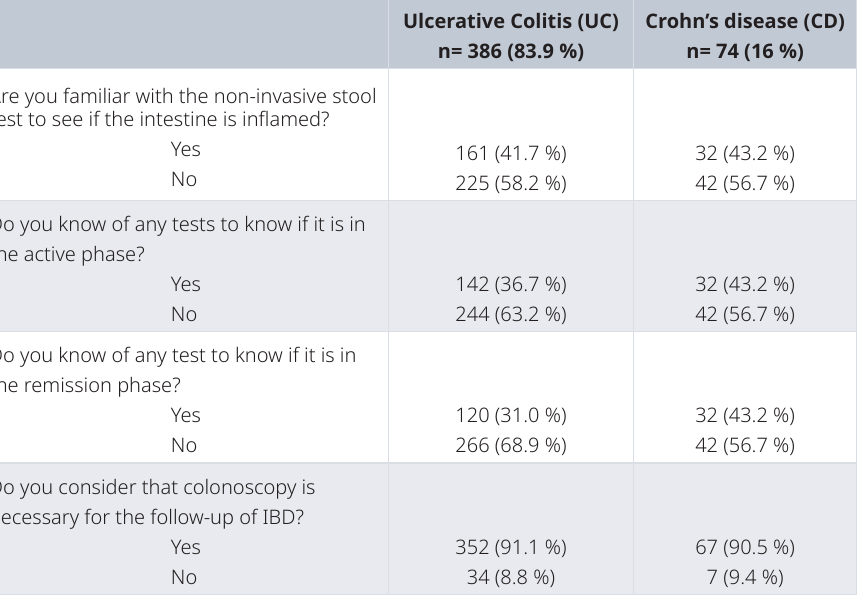
Table 2. Participant knowledge of IBD